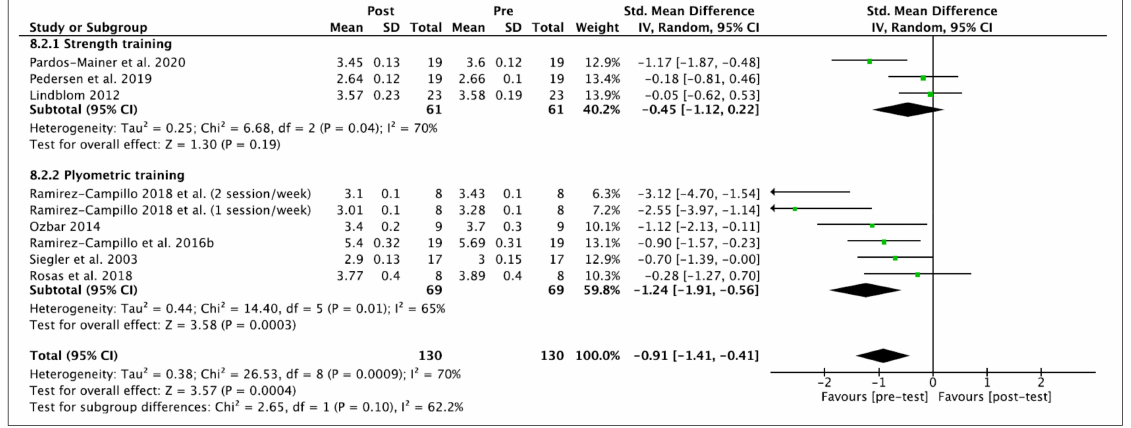
Figure 5. Forest plot of within-mode effect sizes with 95% confidence intervals (CIs) in time of linear sprint (s) e. IV: inverse variance method; SD: standard deviation; Std: